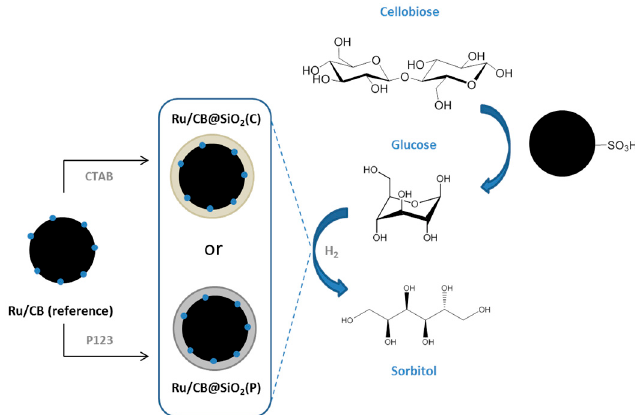
Figure 1. Overview of synthesized catalysts systems and catalytic applications tested.